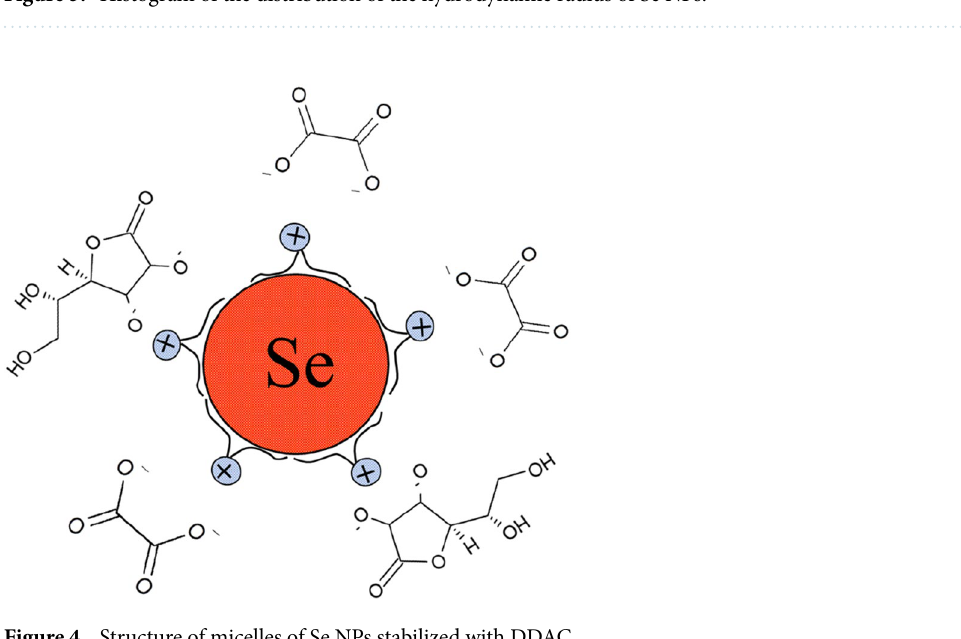
Figure 4. Structure of micelles of Se NPs stabilized with